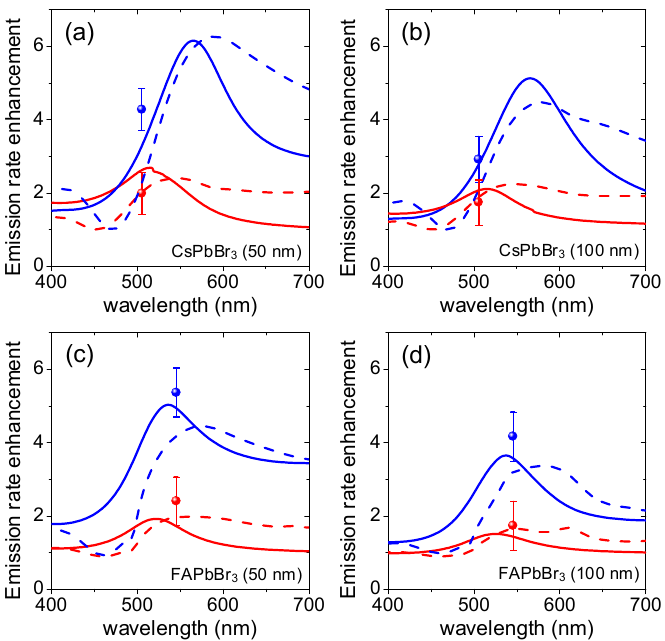
Figure 5. Emission rate enhancement comparison between measurements and calculations. Exper- imental values (spheres) and calculations of emission rate enhancement from the analytical (solid lines) and the electromagnetic simulations (dashed lines) of fluorescence near the interface from single-Au-PS (red) and double-Au-PS (blue) layers with ( a ) 50 nm thick CsPbBr 3 NC film, ( b ) 100 nm thick CsPbBr 3 NC film, ( c ) 50 nm thick FAPbBr 3 NC film, ( d ) 100 nm thick FAPbBr 3 NC film.